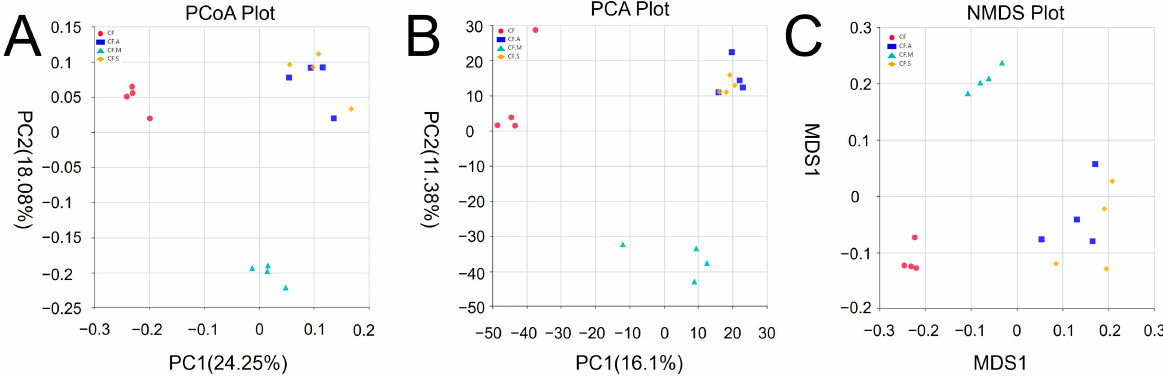
Figure 5. The beta diversity indices of the CF group (CF, CF.M, CF.A, CF.S) of the maize rhizosphere. ( A ) Principal coordinate analysis (PCoA) based on the unweighted Unifrac distances. ( B ) Principal components analysis (PCA) based on operational taxonomic unit (OTU) levels. ( C ) NMDS analysis results based on the unweighted Unifrac distances.